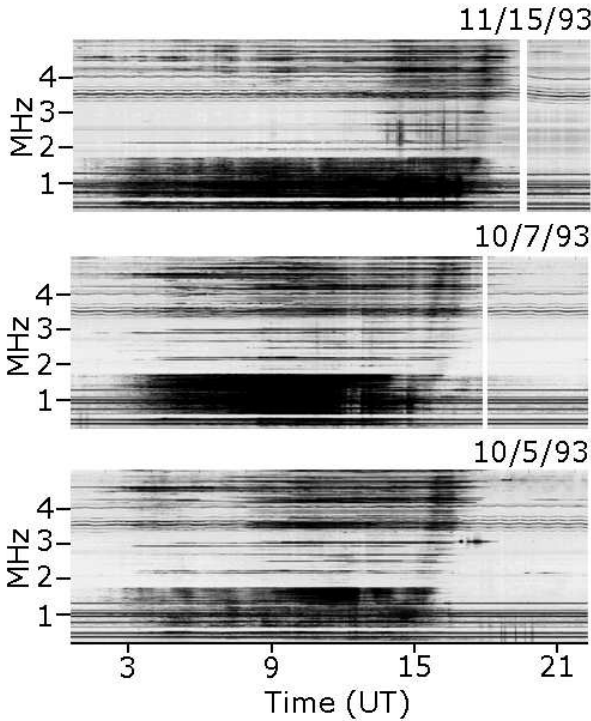
Fig. 4. 50–5000kHz spectrograms recorded at Circle Hot Springs, Alaska, 7 October, 5 October, and 15 November 1993. White pix- √ Hz and black pixels represent els represent PSD below 10 − 8 V/m √ PSD exceeding 10 − 7 V/m Hz. Received LF/MF/HF transmissions are enhanced in amplitude for about one hour just before sunrise, af- ter which they are sharply attenuated. As with the attenuation, the enhancement occurs first at the lowest frequencies, then shifts to higher